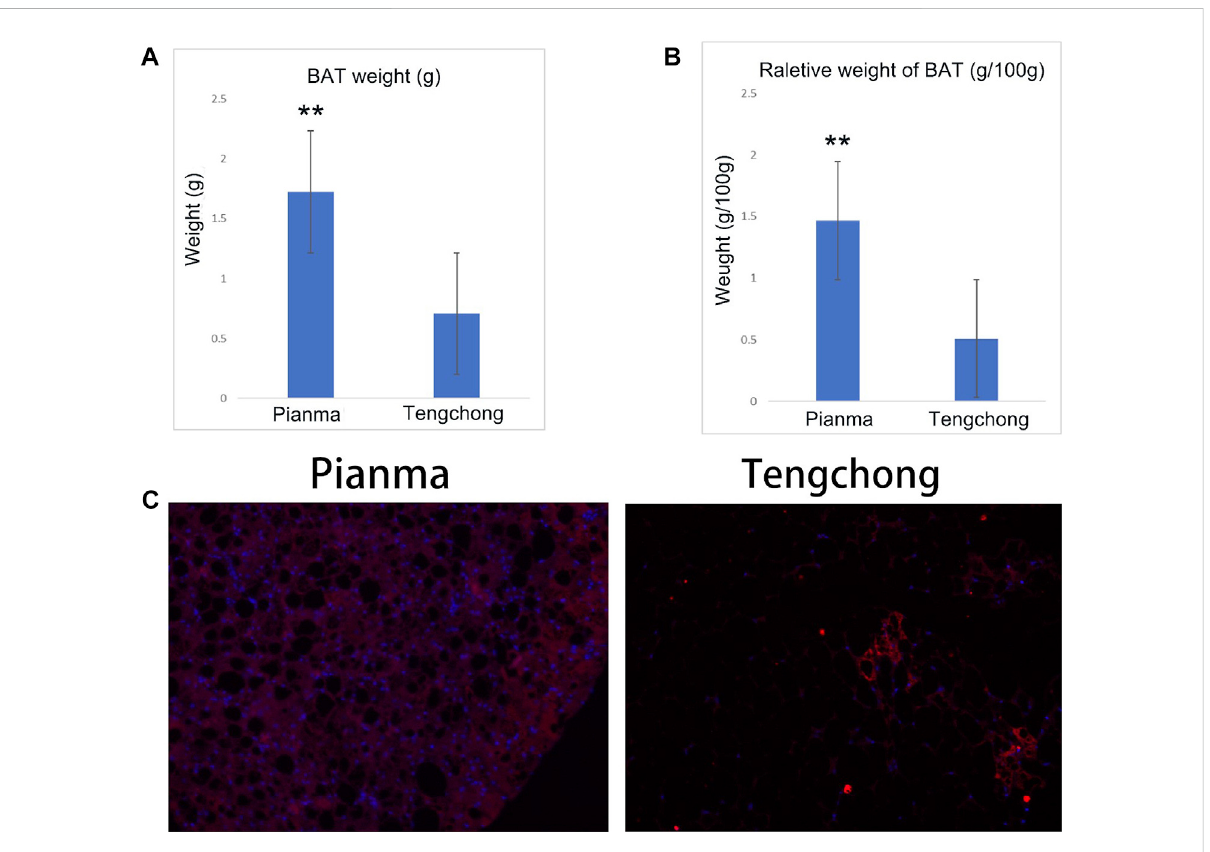
FIGURE 3 ChangesofBATmass (A) ,therelativeweightofBAT (B) andUCP1immuno fl uorescenceimaging (C) in Tupaiabelangeri betweenTCandPM**: p <